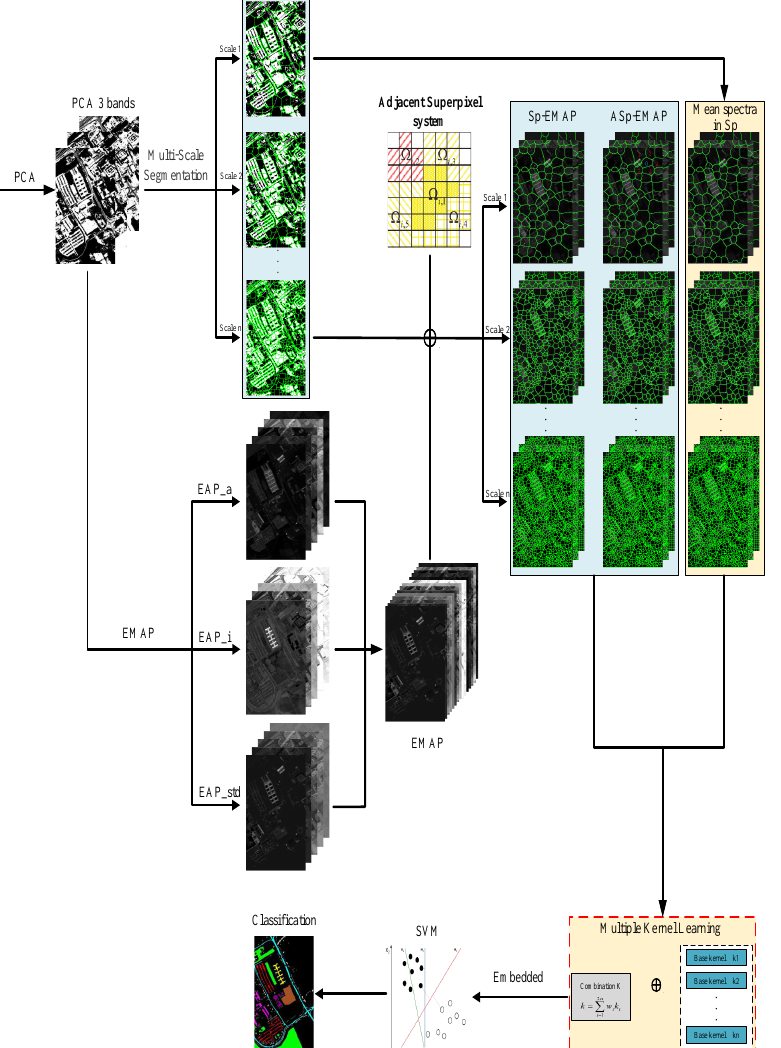
Figure 1. Flowchart of the proposed multiscale, adjacent superpixel-based embedded multiple kernel learning method with the extended multi-attribute profile (MASEMAP-MKL)